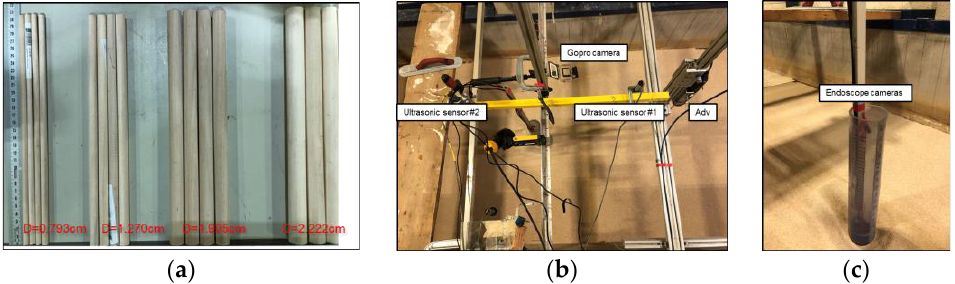
Figure 2. ( a ) Dowel with length 30 cm and diameter 1.27 cm compared with various diameters dowels ( b ) instruments set up ( c ) location of the highest located endoscopic camera.